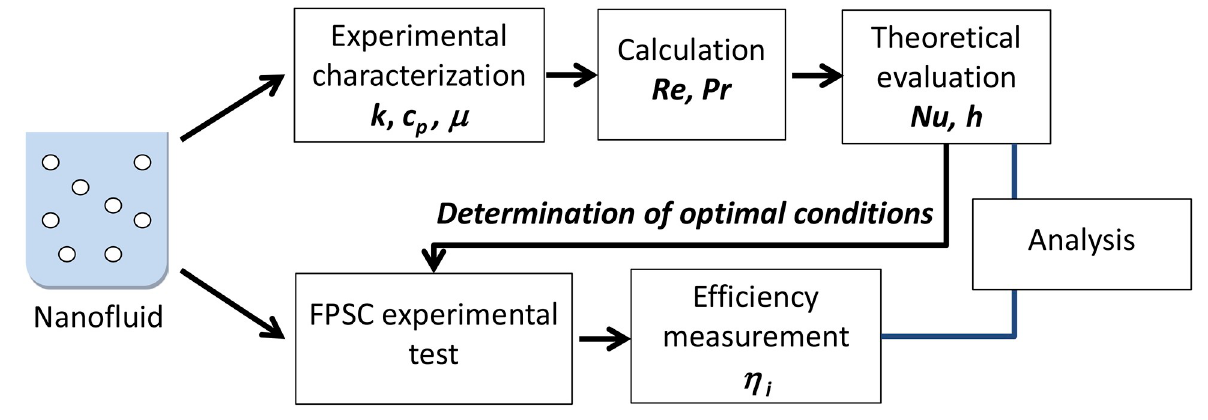
Fig 1. Methodology flow chart.